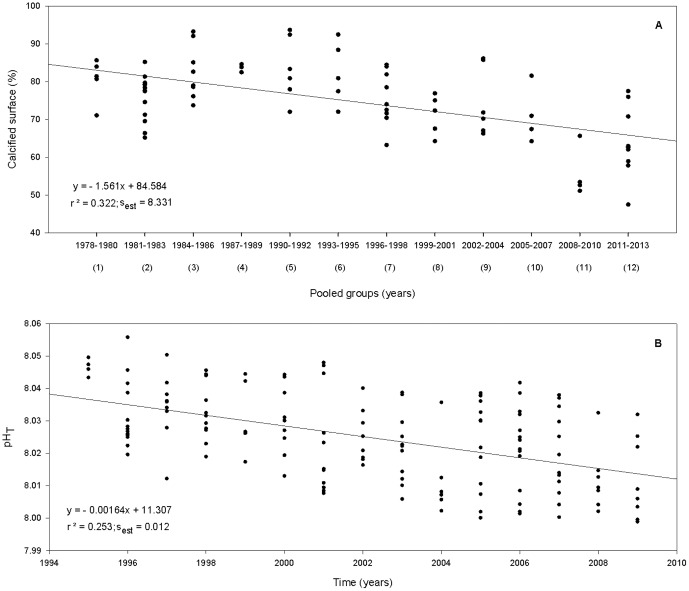
Calcified surface trend of P. pavonica thalli from 1978 to 2013 (A) and oceanic pHT levels from ESTOC dataset between 1995 and 2009 (B).The X value in the equation represents the binned group number (1–12) in three year periods. sest stands for standard error of estimate.